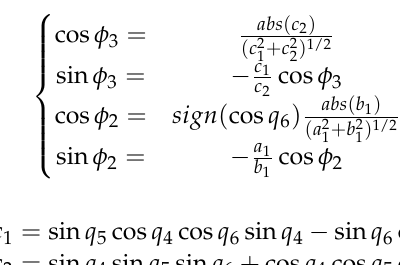
Table 2. Denavit-Hartenberg parameters for